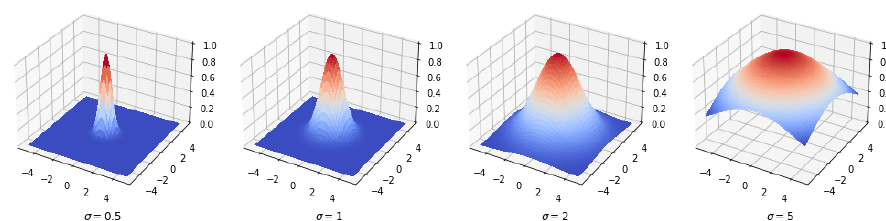
Figure 4. Effect of σ on similarity. The four subplots represent the Gaussian kernel function surfaces of the surrounding points and the center point for different values of the σ . The closer the color is to red, the closer the similarity is to 1. The closer the color is to blue, the closer the similarity is to 0. As the σ increases, the steep surface gradually becomes flatter, and the red area gradually increases, which means that the number of points similar to the center gradually increases.